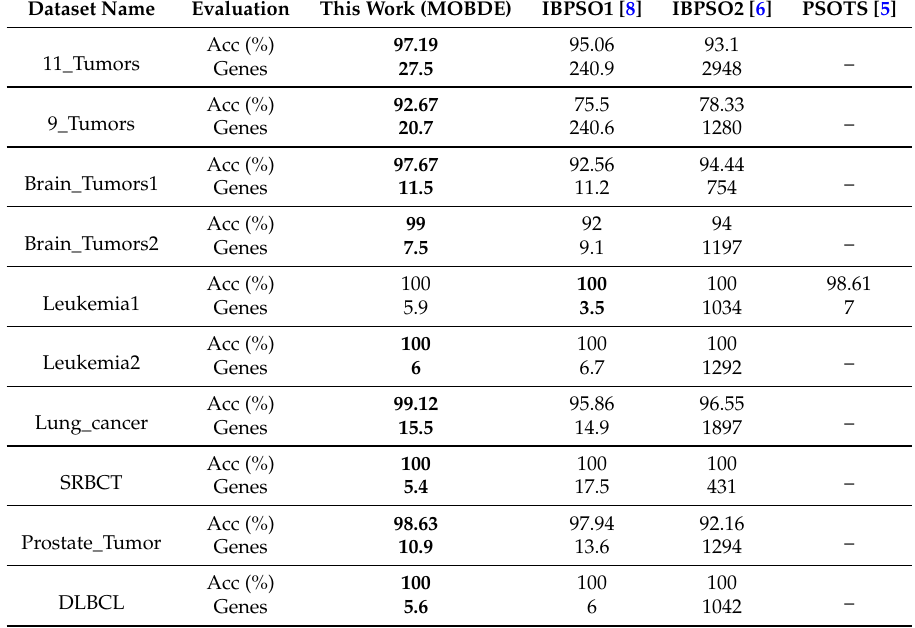
Table 11. Comparative experimental results of the binary differential evolution algorithm with some single-objective methods.